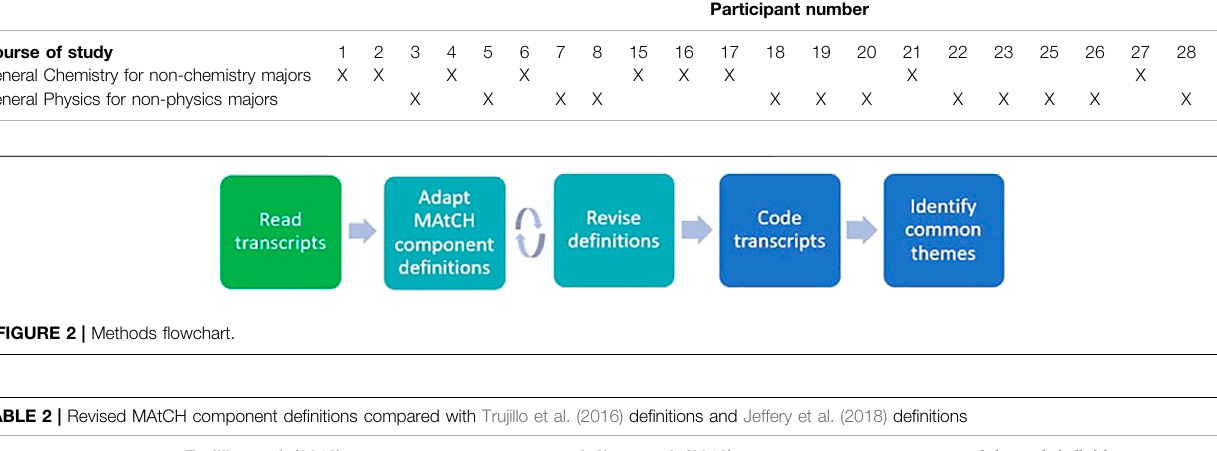
TABLE 1 | Participant breakdown for the course participants were studying.